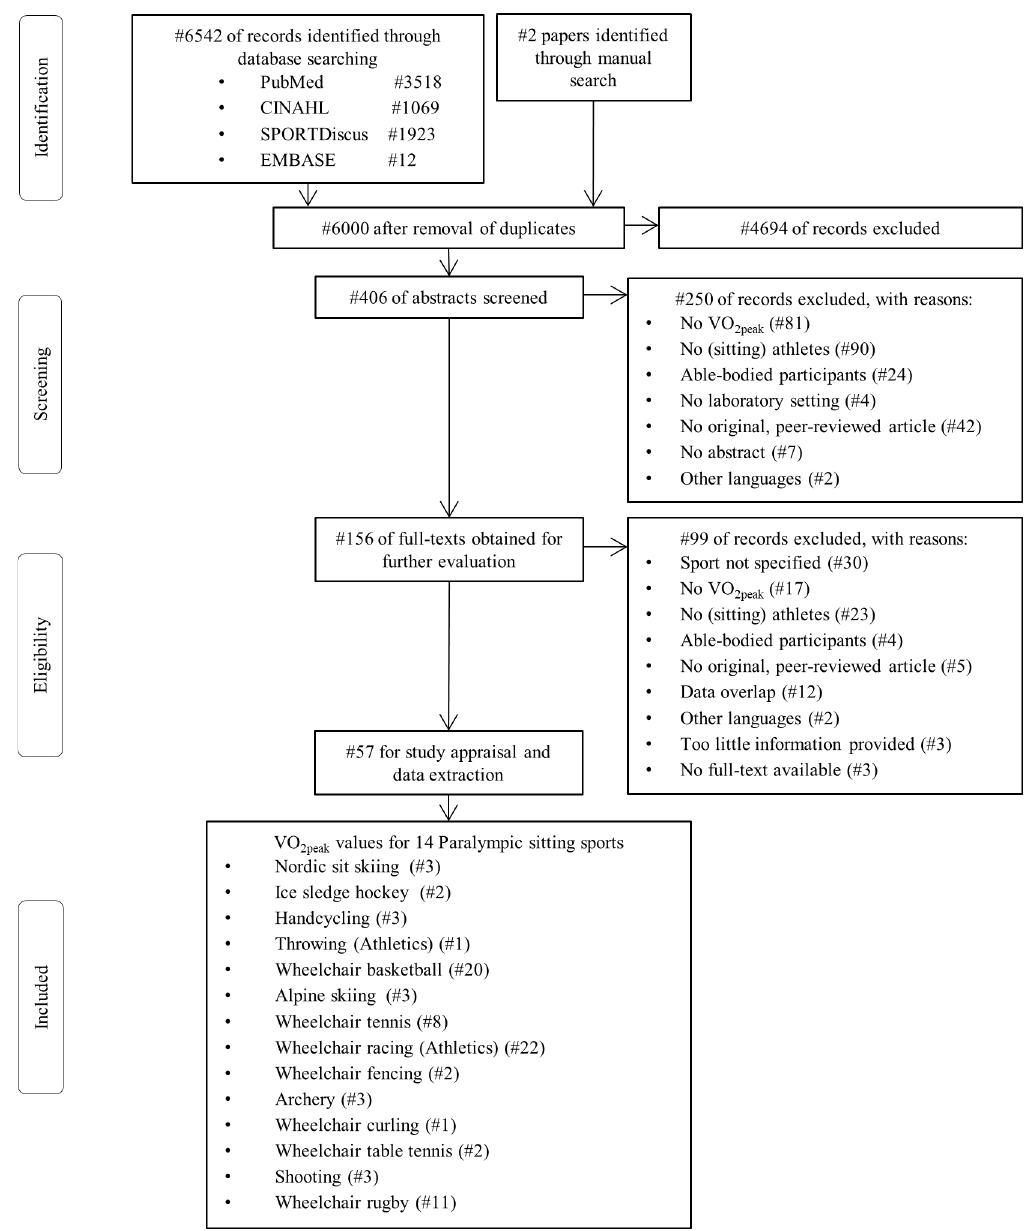
Fig 1. Preferred Reporting Items for Systematic reviews and Meta-Analyses (PRISMA) flowchart depicting the study identification, screening, eligibility and inclusion process. The sports disciplines presented in the box at the bottom are ranked according to their absolute peak oxygen uptake (VO 2peak ) values, from highest to lowest. (cid:3) Note that 1) some of the studies provide values for more than one sports discipline and 2) athletics was divided into throwing events and wheelchair racing due to the distinct differences in movement demands between these two